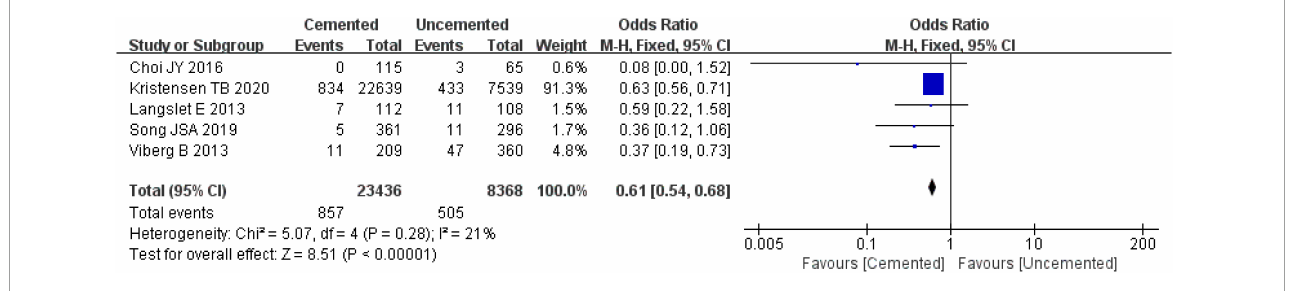
FIGURE10 Forest plot for comparison of re-operation rates between cemented bipolar hemiarthroplasty (CBH) group and uncemented bipolar hemiarthroplasty (UCBH) group.